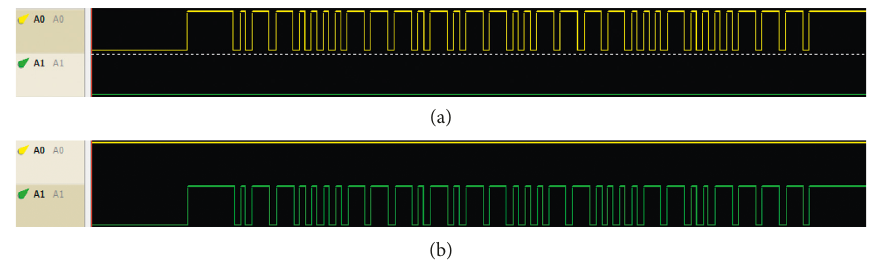
Figure 16: IR signals of (a) source data and (b) recovered data associated with channel change button.